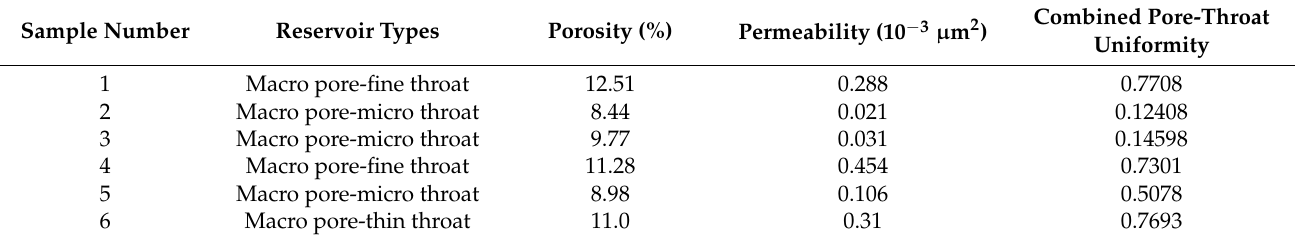
Table 4. The combined pore-throat uniformity of different pore-throat combination